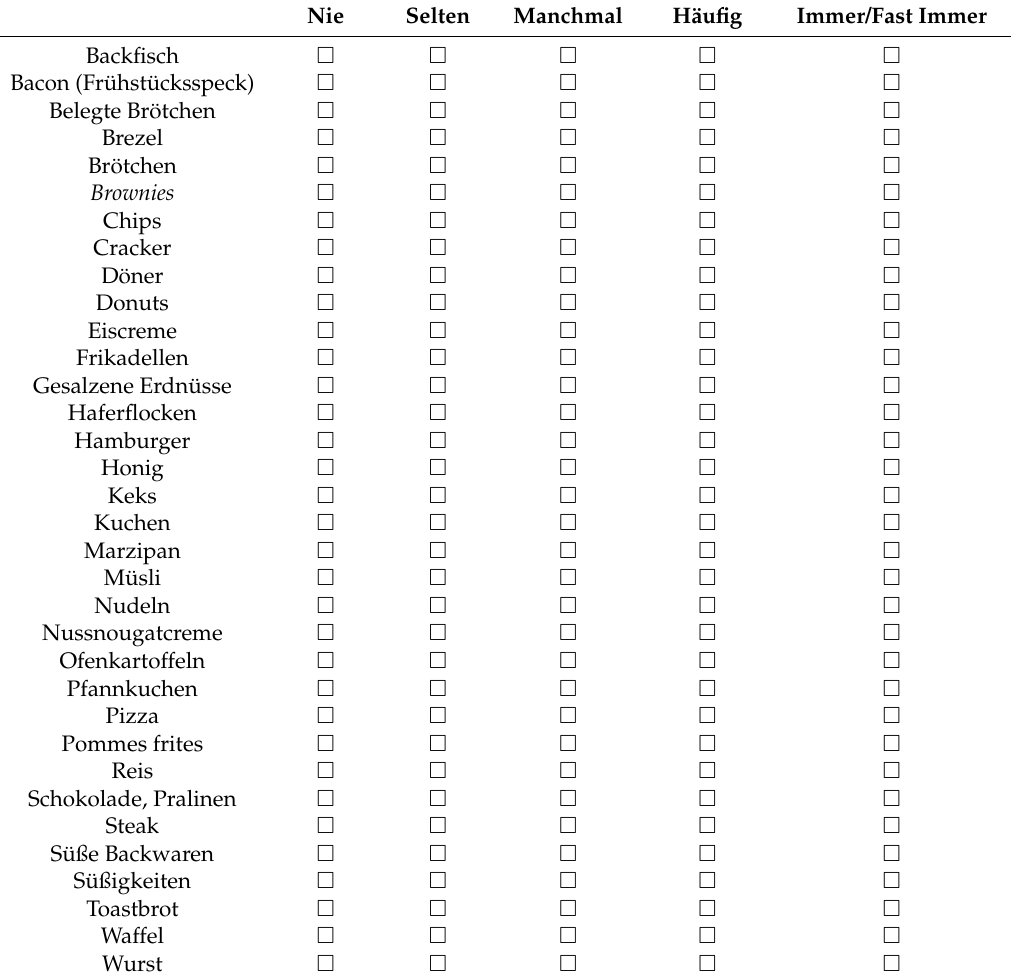
Table A2. List of foods and frequency to which cravings are given